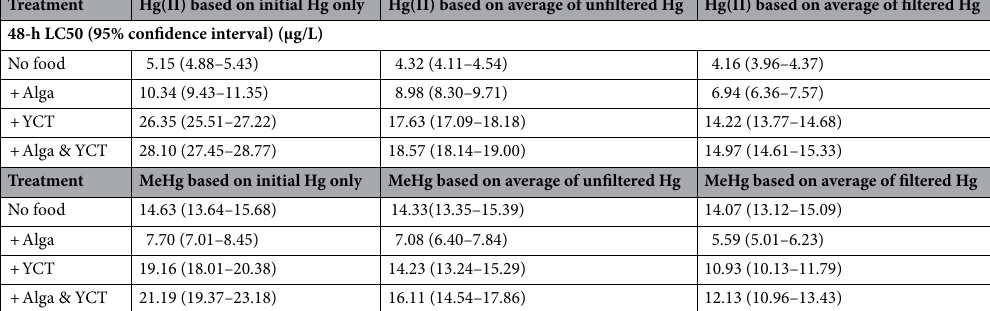
Table 1. Calculated 48-h median lethal concentration (LC50) and the associated 95% confidence interval for inorganic mercury [Hg(II)] and methylmercury (MeHg) to Daphnia magna under different treatments. Three values of 48-h LC50 values of Hg(II) and MeHg are based on measured initial concentrations only ( column 1 ), average of initial and final unfiltered concentrations ( column 2 ), or average of initial and final filtered concentrations ( column 3